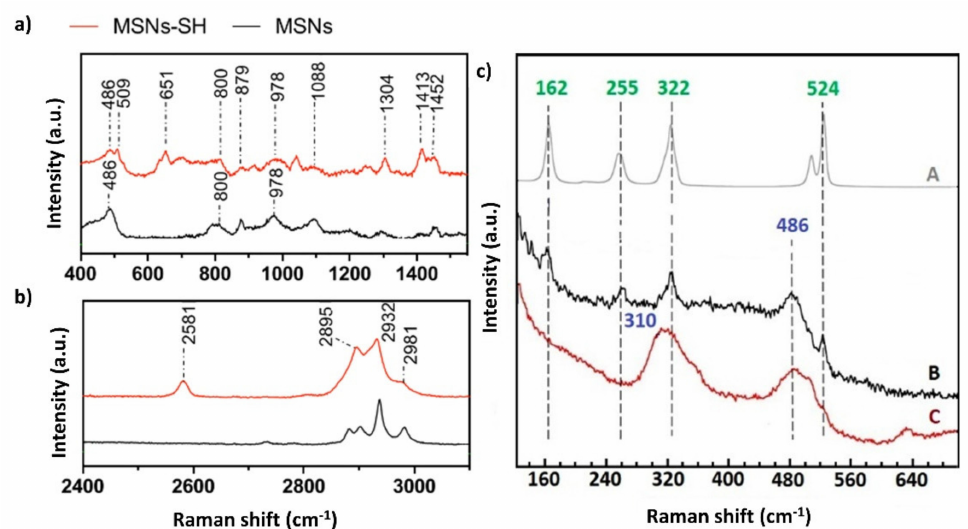
Figure 14. ( a ) Raman spectra of mesoporous silica pristine MSN (black line), mesoporous silica modified with SH group MSN–SH (red line) in the range 400–1500 cm − 1 , ( b ) Raman spectra of mesoporous silica pristine MSN (black line), mesoporous silica modified with SH group MSN–SH (red line) in the range 2400–3100 cm − 1 , ( c ) Raman spectra cisplatin A (grey line), cisplatin:MSN B (black line), cisplatin:MSN–SH C (red line). Adapted with permission from [222], Copyright 2019 American Chemical Society.